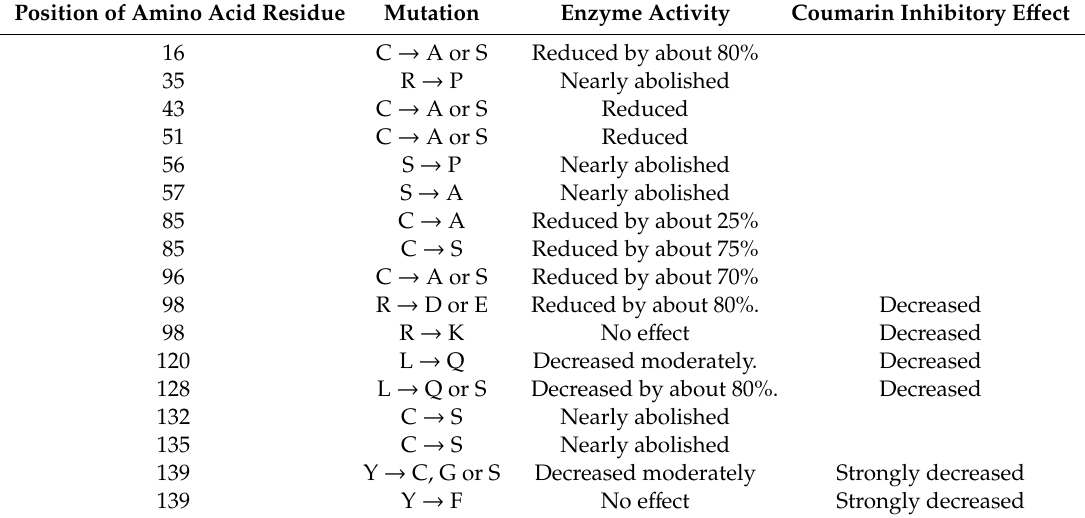
Table 2. Amino acid residues vital for the VKOR functioning or strength of the coumarin inhibitory e ff ect (based on https: // www.uniprot.org / uniprot / Q9BQB6)